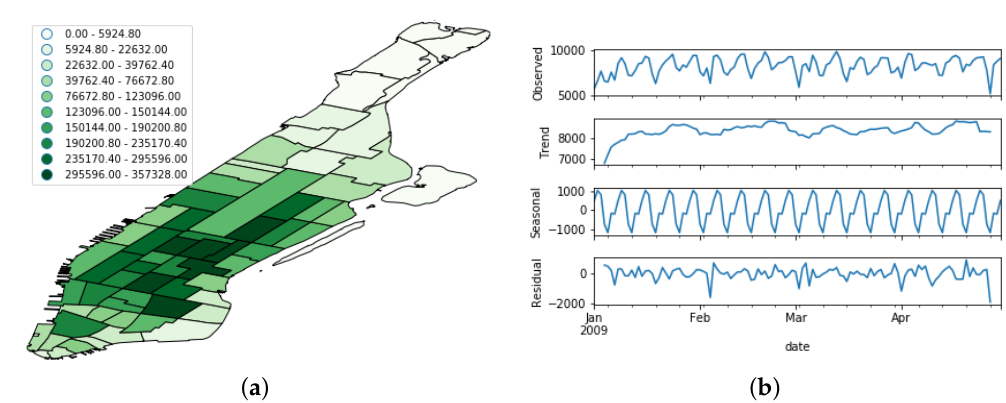
Figure 8. Distribution of the taxi demand dataset. ( a ) Spatial distribution; ( b ) Temporal evolution. The uppermost figure shows the raw time series, whereas the other bottom ones depict its